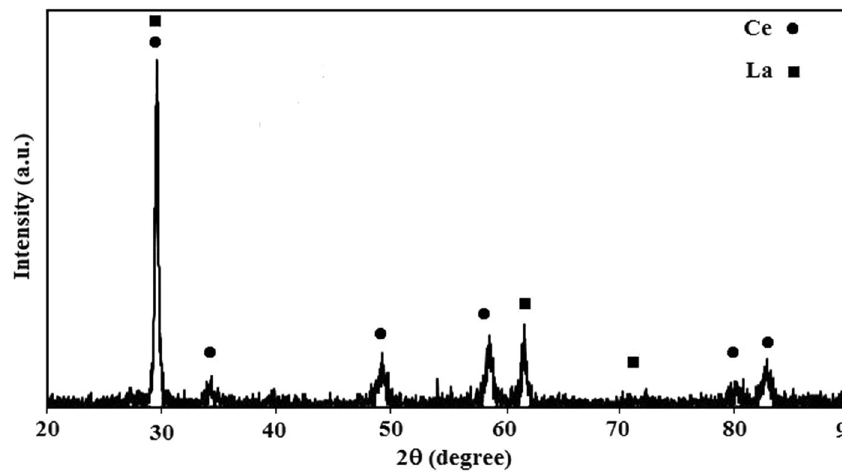
Fig. 1 XRD pattern of the